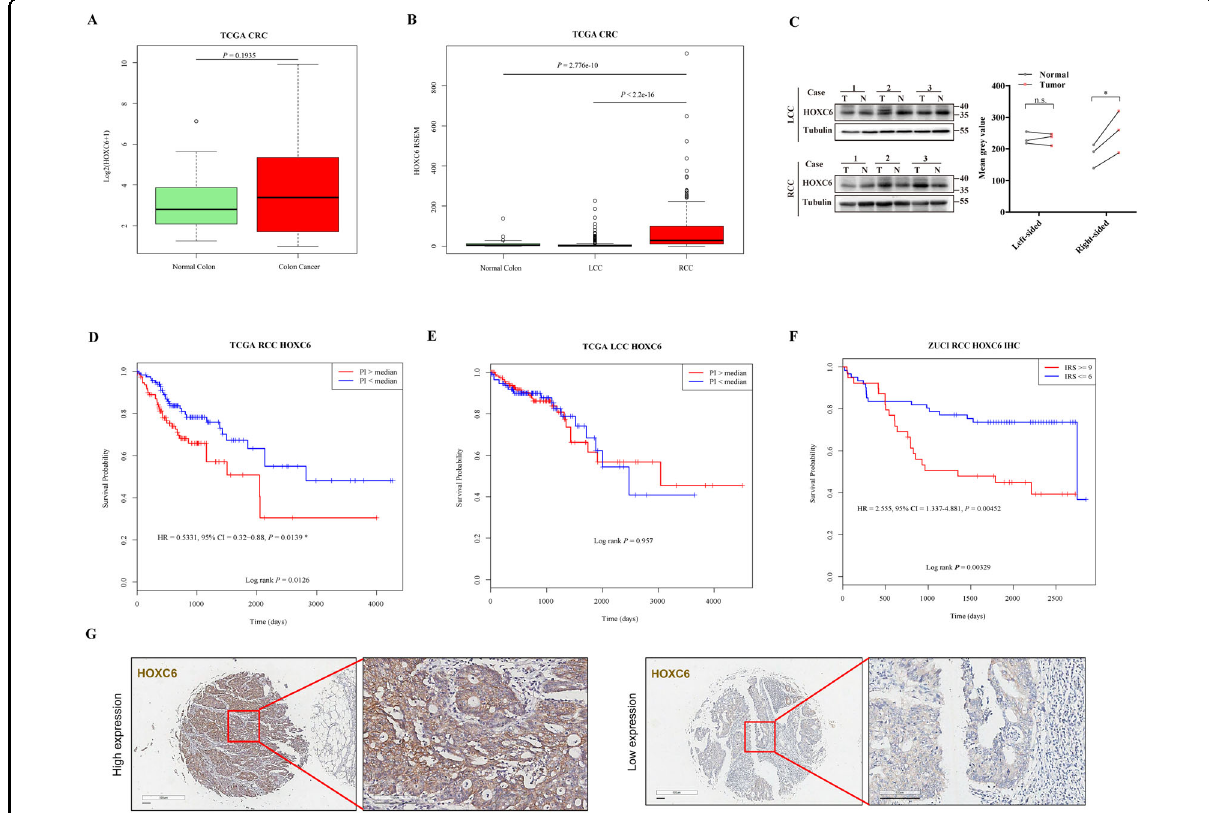
Fig. 1 Expression of HOXC6 and prognostic value in human CRC. A No difference in HOXC6 expression was observed between CRC and normal tissues by using TCGA samples. B HOXC6 was overexpressed in RCC but not in LCC compared to normal colon tissues based on TCGA samples. C Left: Western blot of fresh-frozen tissues from RCC and LCC showed that HOXC6 was overexpressed in RCC but not in LCC compared to paired adjacent normal colon tissues. Right: Adjusted mean gray values by control gray values of WB. D . KM plot showing that HOXC6 high-expression group had poor prognosis compared to the low-expression group in RCC. E The KM plot showed that there was no prognostic difference between the HOXC6 high-expression and low-expression groups in LCC. F KM plot showing that the HOXC6 high-expression group had a poor prognosis compared to the low-expression group in the ZUCI RCC samples ( n = 100). G Representative images of the HOXC6 high-expression and low- expression groups. Scale bars indicate 100 µm. *: P <